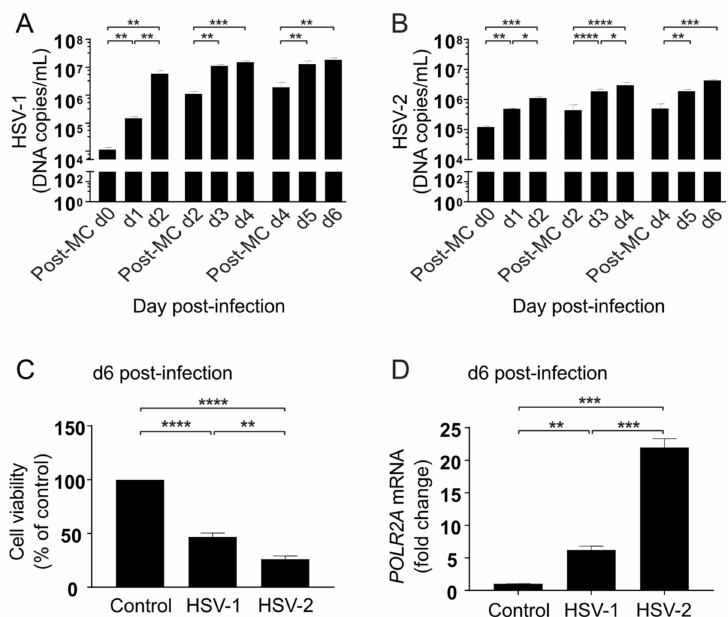
Figure 8. Neuronal responses followed six days after HSV infection. Ninety days old neurons infected for one hour with HSV-1 or HSV-2 at MOI = 0.1 and followed for six days post-infection. ( A , B ) HSV-1 DNA copies/mL measured with qPCR in the cell medium, directly after the medium change (MC) following inoculation (Post-MC d0) 24 h post-infection (d1) and 48 h post-infection (d2), shows that replication of HSV-1 ( A ) and HSV-2 ( B ) increases during the first two days (d0–d2). Viral DNA measured directly after the medium change 2 days post-infection (Post-MC d2) and again after 24 h (d3) and 48 h (d4) shows that replication continues 3–4 days post-infection. Viral DNA measured directly after the medium change 4 days post-infection (Post-MC d4) and again after 24 h (d5) and 48 h (d6) shows that replication continues 5–6 days post-infection. Bars represent mean of three separate differentiations from two iPSC lines +/ − SEM. ( C ) Six days post-infection, neuron viability is reduced with 47.0% and 68.5% by HSV-1 and HSV-2, respectively. Bars represent mean of three separate differentiations from two iPSC lines +/ − SEM. ( D ) Six days post-infection, human RNA polymerase II (POLR2A) mRNA is increased 6.2-fold by HSV-1 and 22.0-fold by HSV-2. Bars represent values from two separate differentiations from one iPSC line +/ − SEM. * p < 0.05, ** p < 0.01, *** p < 0.001 and **** p < 0.0001 from Student’s t